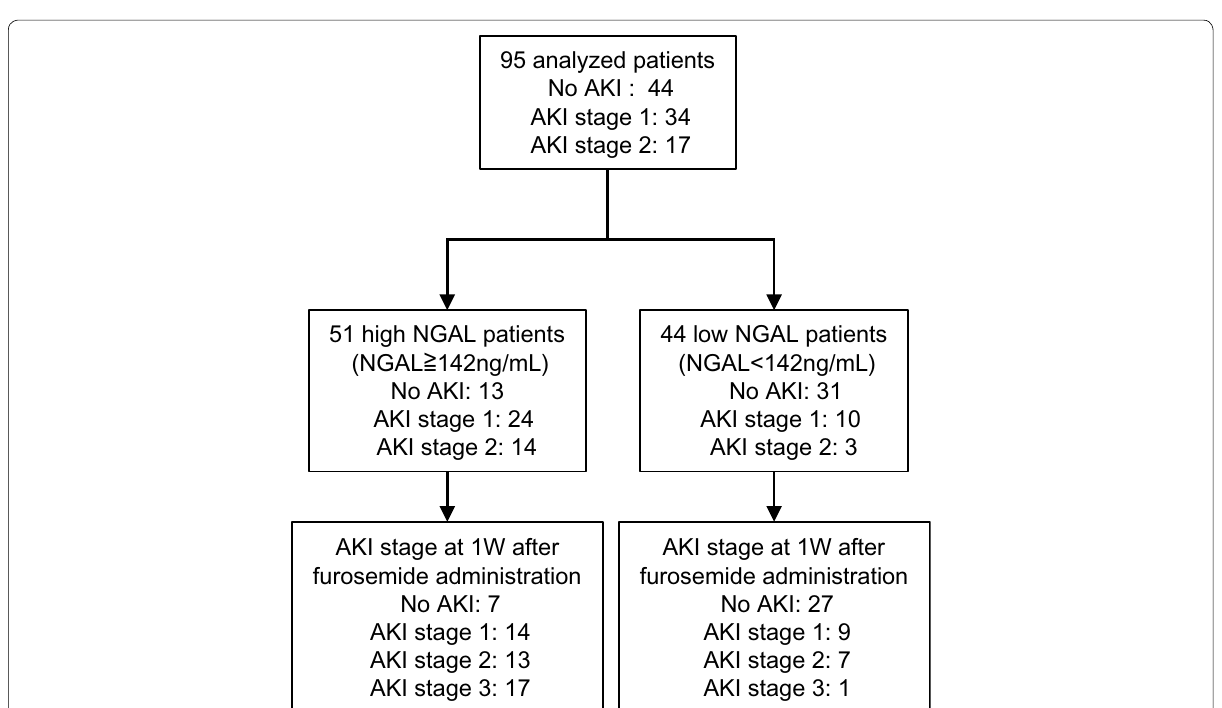
Fig. 4 Distribution of ICU patients determined by the plasma NGAL level. NGAL, neutrophil gelatinase-associated